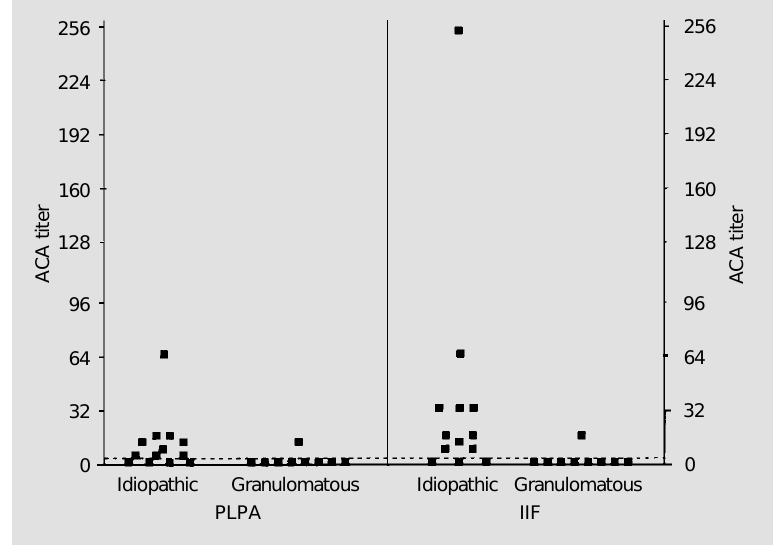
Figure 1 - ACA-PLPA and ACA-IIF levels in patients with “idiopathic” and “granulomatous” AD. The dotted lines represent the upper normal level for each